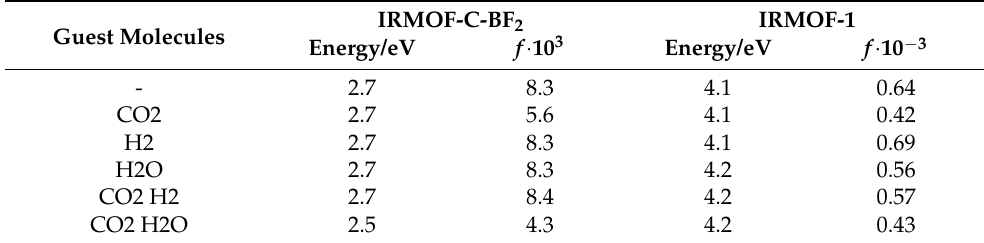
Figure 3. Optimized geometries of bright excited states reported in Table 5 for the interaction between IRMOF-C-BF 2 and guest molecules. The energies for these are shown in Table 4. The structures presented are, considering the guest, as ( a ) IRMOF-C-BF 2 -CO 2 , ( b ) IRMOF-C-BF 2 -H 2 , ( c ) IRMOF-C- The specified distances and angles are shown in Angstrom (Å) and degrees. Coordinates in xyz format available in the Supplementary Materials (Table S2). Table 5. Optimized energies and oscillator strengths of the brightest transitions of IRMOF-C-BF 2 , in the presence and absence of guest molecules. A column including the results for IRMOF-1 is included as a